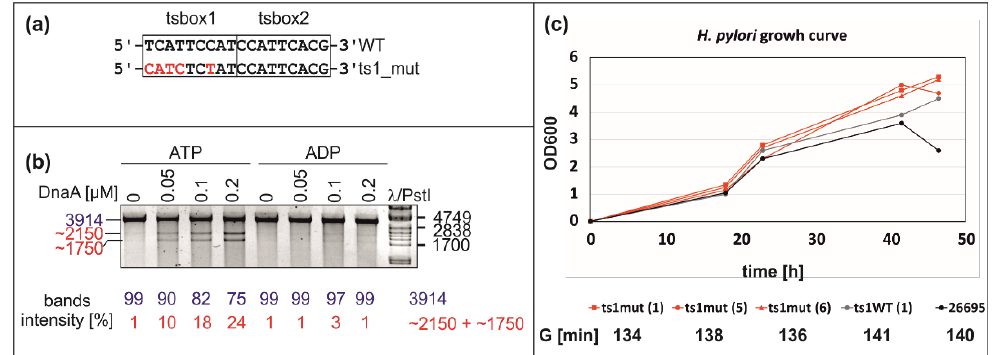
Figure 7. Analysis of the influence of the ts1 box mutation on the functionality of the oriC region. ( a ) The sequence of the wild-type and mutated ts1 box is shown. The mutated nucleotide residues are marked in red. ( b ) P1 nuclease analysis of the pori_ts1mut plasmid unwinding by ATP–DnaA and ADP–DnaA. After incubation with the indicated amounts of DnaA and ATP or ADP, the pori_ts1mut plasmid was treated with P1 nuclease, BglII digested, and resolved on 1% agarose gels. The sizes of the λ /PstI DNA ladder bands and the expected DNA restriction fragments (in base pairs) are indicated to the left and right of the gel images, respectively. ( c ) Analysis of H. pylori growth under microaerobic conditions. H. pylori was inoculated in Brucella broth with an OD 600 = 0.005 and cultured microaerobically until a stationary phase of growth was reached. The growth curves of the wild-type (ts1WT), and three mutant clones (ts1mut) are shown. Generation times (G) were calculated for the H. pylori 26695 wild-type and mutant strains grown in liquid cultures for a time of approximately 0–18 h of growth.